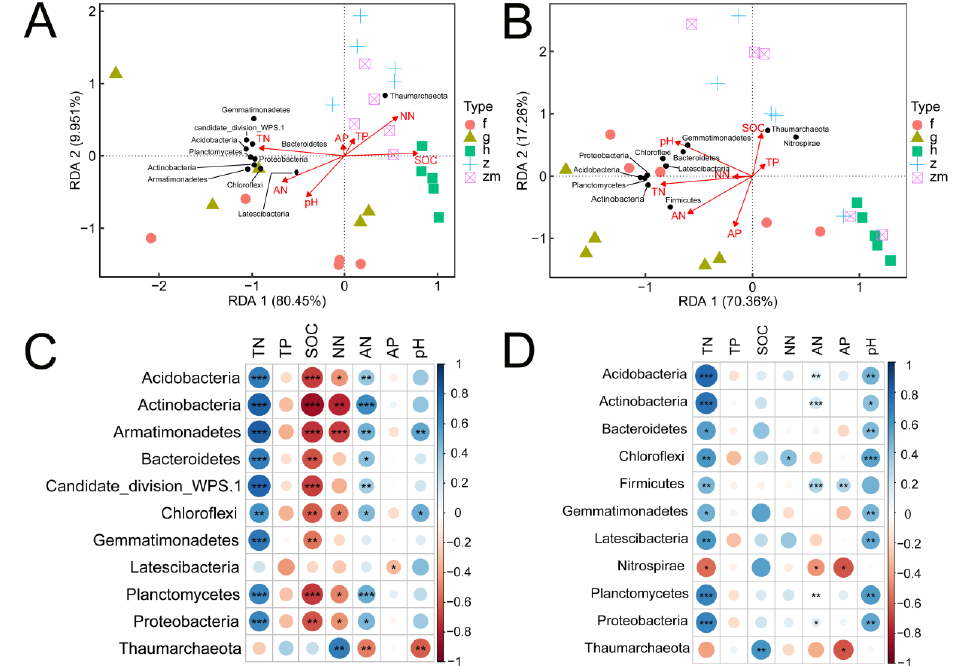
Figure 7. Ranking diagram of the redundancy analysis (RDA) to identify the relationship between soil nutrients (red arrows) and the richness of soil microbial phyla (black dots) at 0 – 20 cm soil depth ( A ) and 20 – 40 cm soil depth ( B ), respectively; Spearman rank correlation coefficients between soil nutrients and the abundance of soil microbial phyla at 0 – 20 cm soil depth ( C ) and 20 – 40 cm soil depth ( D ), respectively. *, ** and *** indicate obvious difference at p < 0.05, p < 0.01 and p < 0.001 between soil nutrients and the abundance of soil microbial phyla.